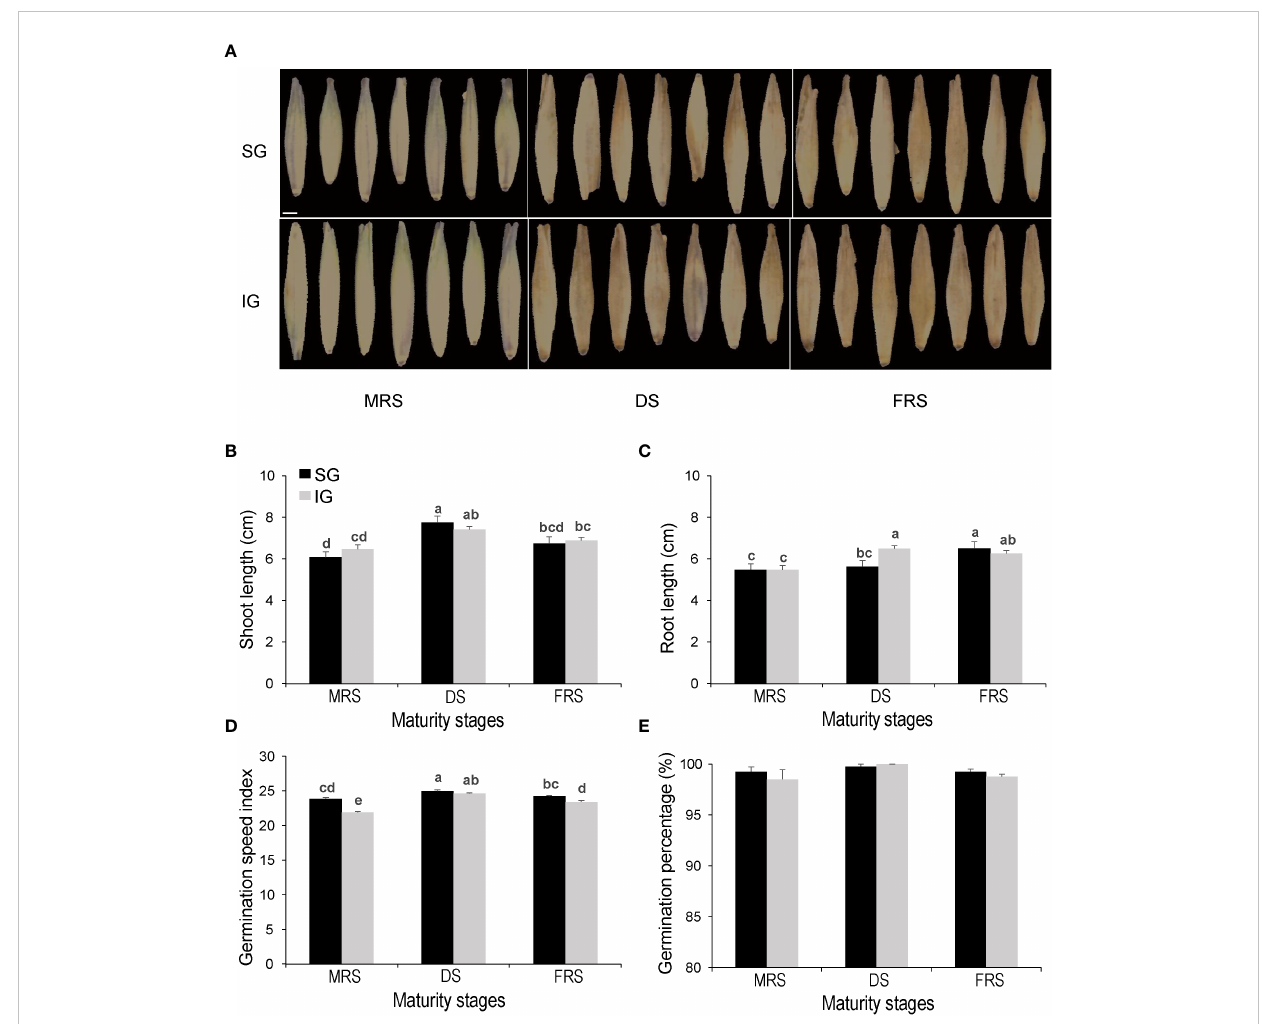
FIGURE 2 Germination and vigor tests, sorting of Siberian wild rye seeds at different developmental stages, and grain positions. (A) Seed images. (B) Shoot length. (C) Root length. (D) Germination speed index. (E) Germination percentage (%). Different lowercase letters indicate signi fi cant differences at different stages and grain positions at the P<0.05